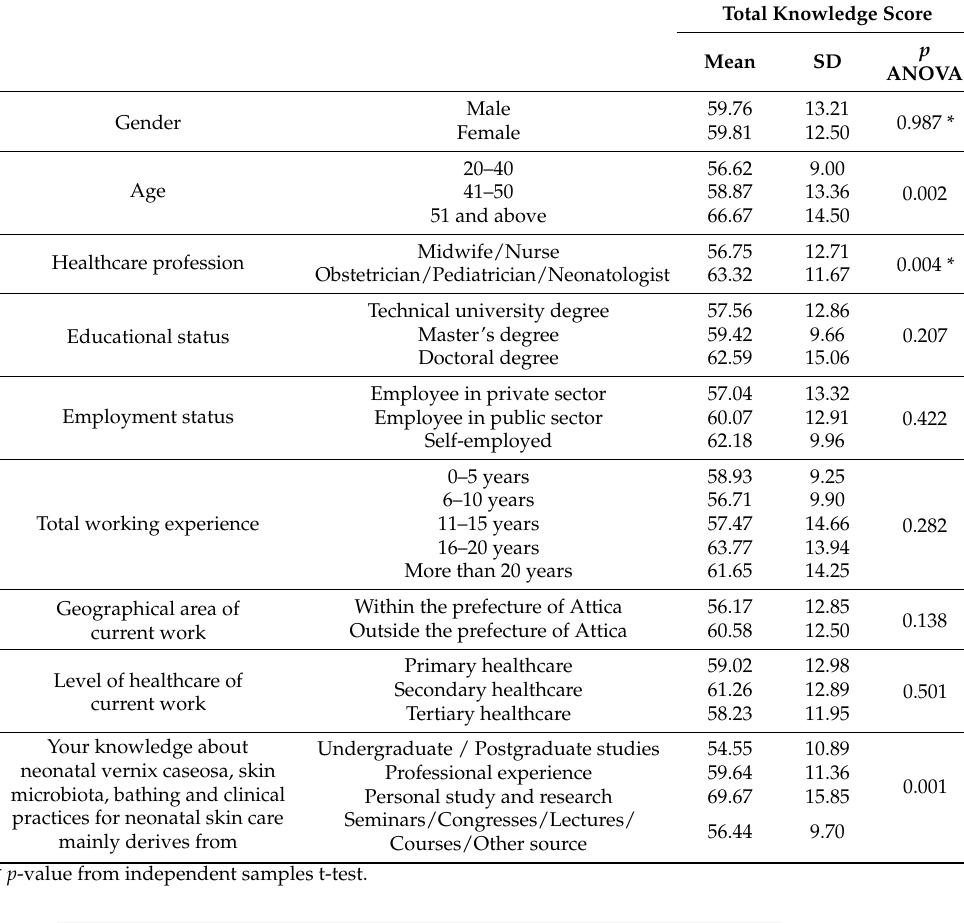
Table 6. Associations among participants’ total knowledge score and demographic and occupational characteristics.